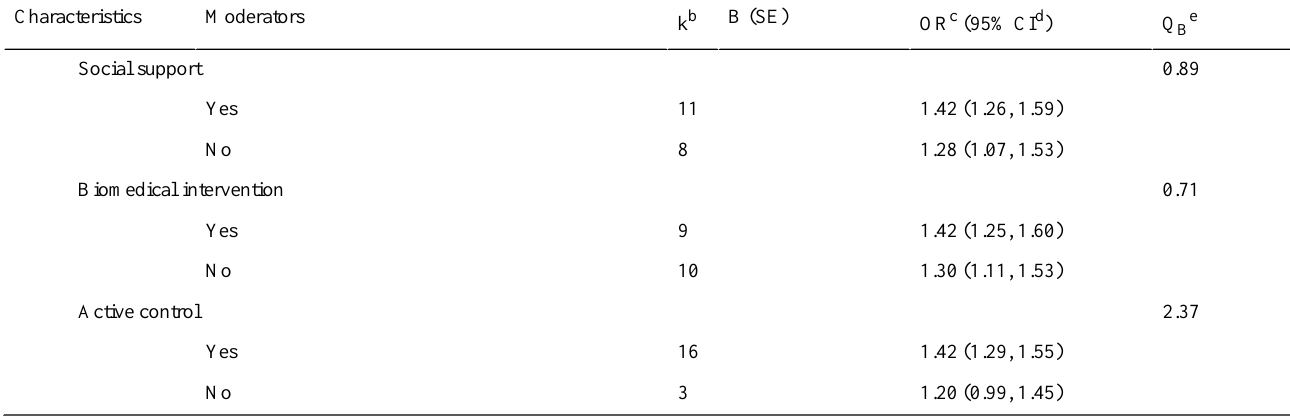
Number of interventions.